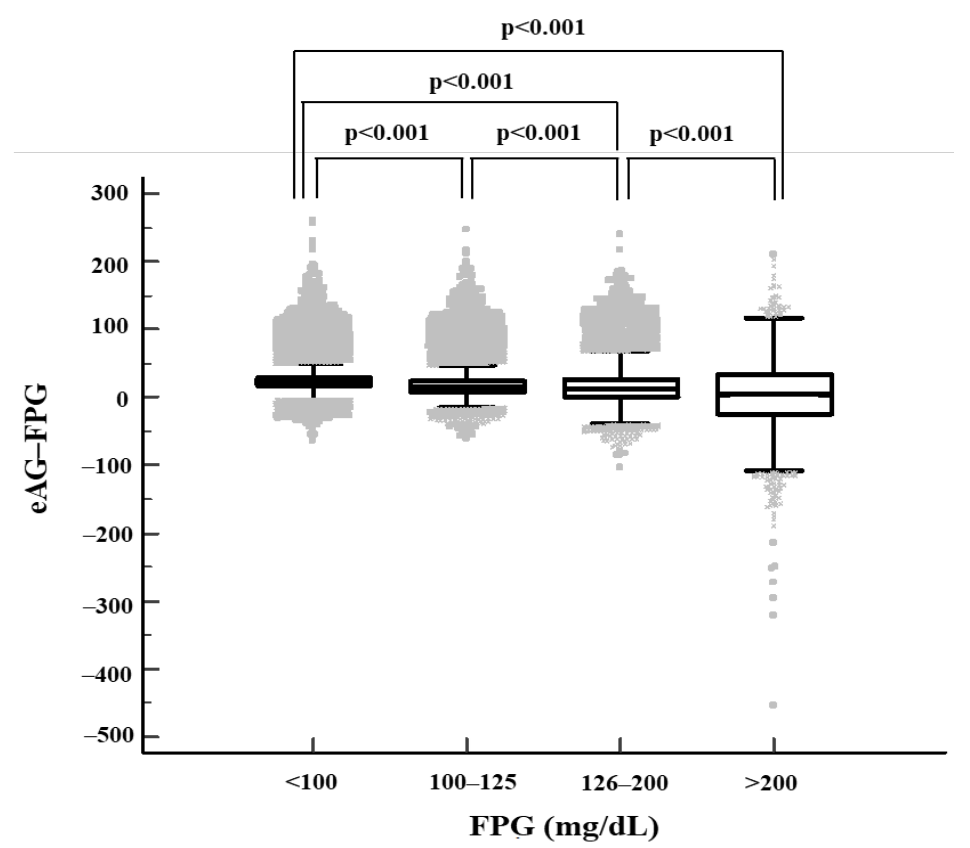
Figure 2. Scatter and distribution plots of differences between eAG and FPG in the study subjects. Box limits and horizontal lines within boxes represent interquartile ranges and the median, respectively. The upper and lower whiskers indicate the 97.5th and 2.5th percentiles, respectively. p value is from Wilcoxon rank sum test. * eAG – FPG: Difference between eAG and FPG.